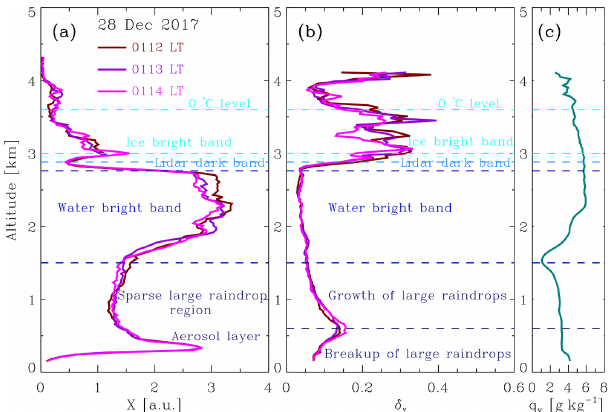
Figure 5. Lidar profiles for slightly strong precipitation that reached the surface (in light rain). (a) Range-corrected 355nm signal X profiles covering the period from 02:30 to 02:32LT on 28 Decem- ber 2017; (b) 355nm volume depolarization ratio δ v profiles cov- ering the same period; (c) 1h averaged lidar q v profile centered at 02:31LT on the same